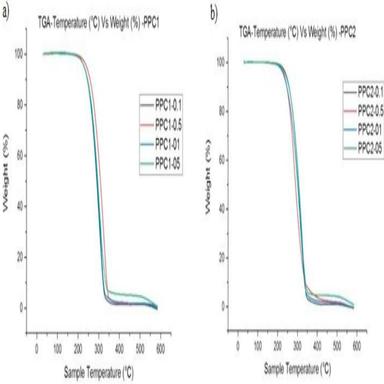
TGA Results for a) PPC1; b) PPC2.